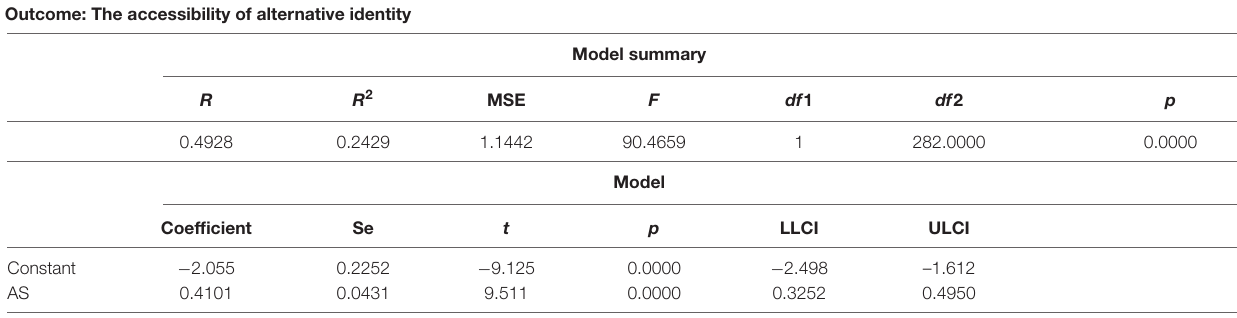
TABLE 4B | Results of analyzing variables related to the intent to purchase alternative vs. focal identity-related product.